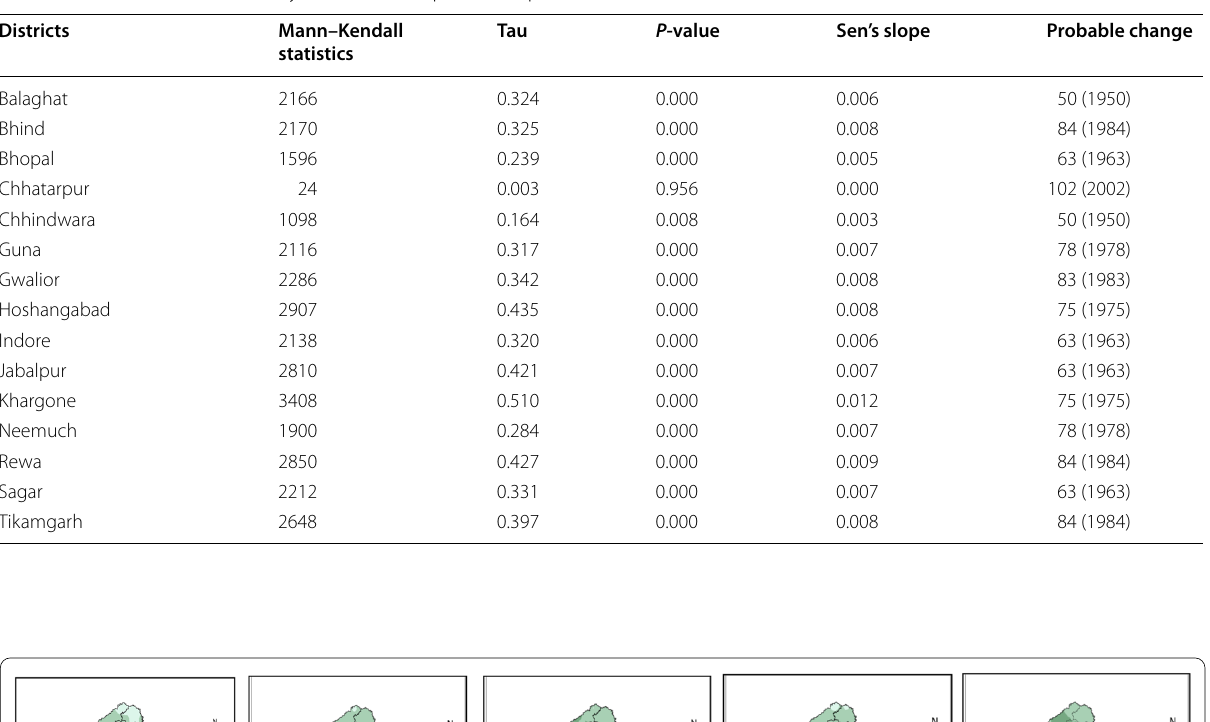
Table 4 The trend in annual minimum temperature of 115 years (1901–2016) of the 15 districts of Madhya Pradesh state of central India under study as per Mann–Kendall test and Sen’s estimator showing a significant increasing trend for minimum temperature in all